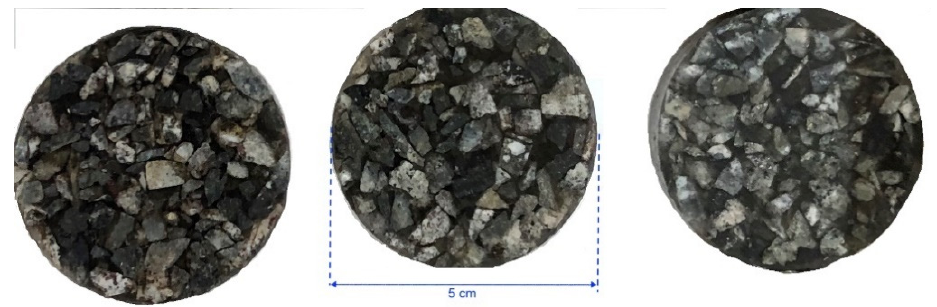
Figure 1. Images of some copper ore samples used in the study.